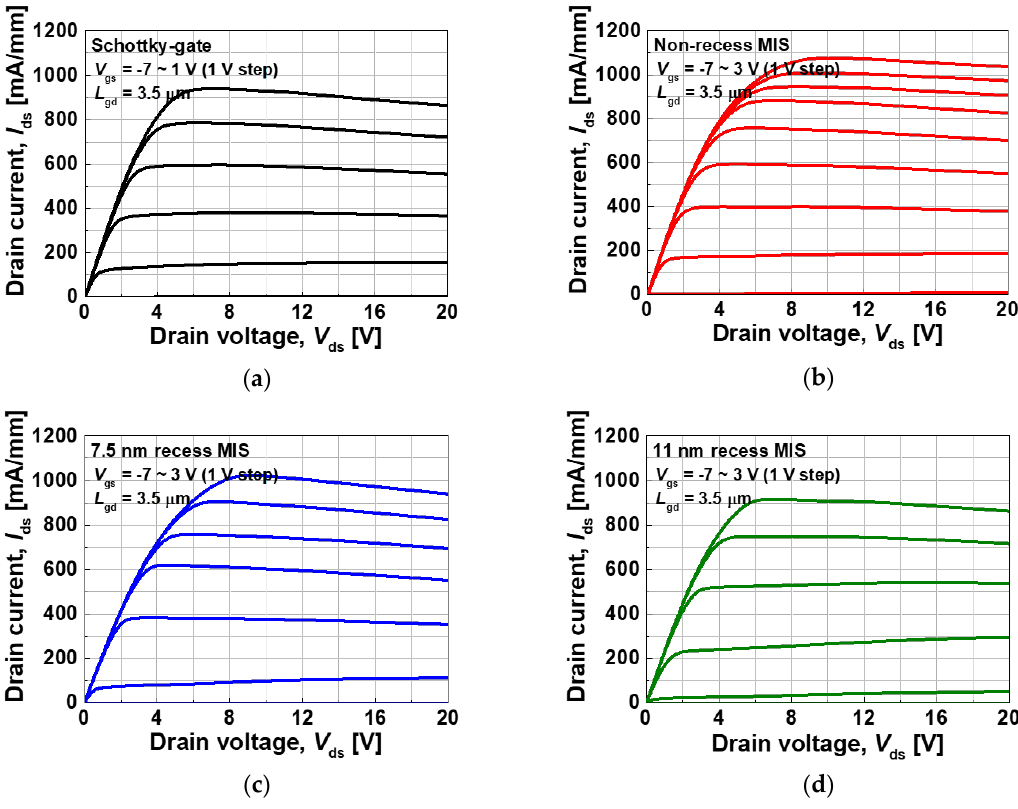
Figure 4. Output characteristics of the fabricated devices; ( a ) Schottky-gate, ( b ) non-recess MIS, ( c ) 7.5 nm recess MIS, and ( d ) 11 nm recess MIS